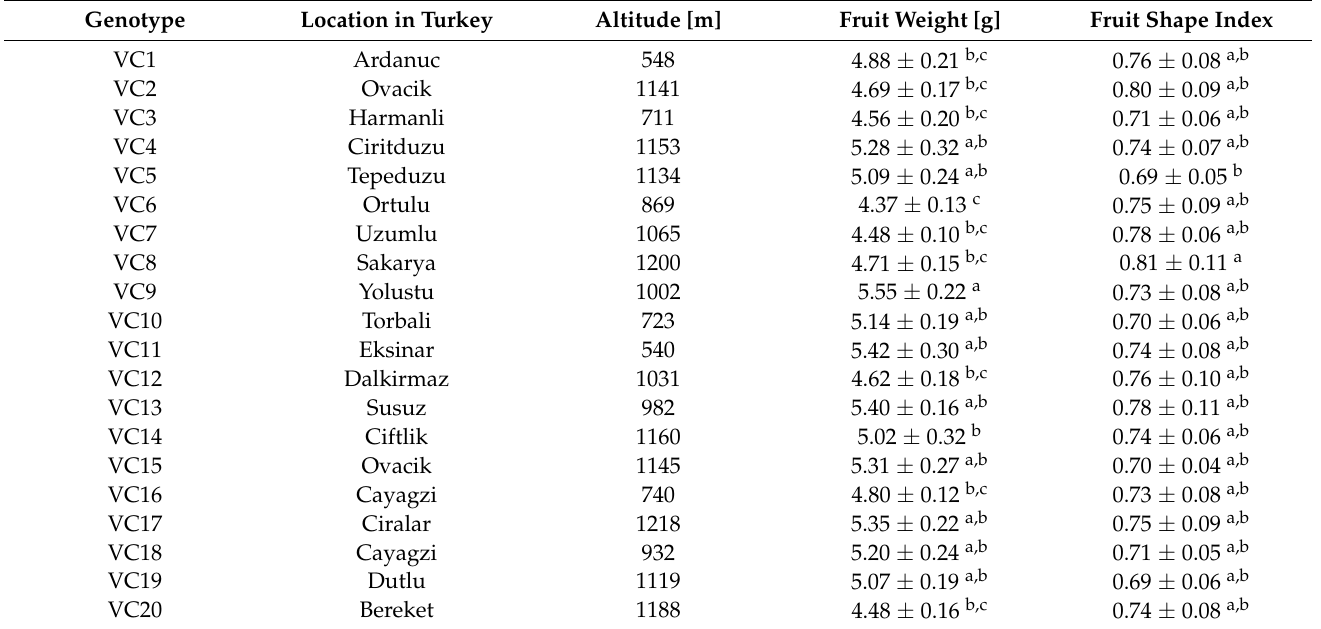
Table 1. Characteristics of analyzed M. nigra fruits; average fruit weight and fruit shape